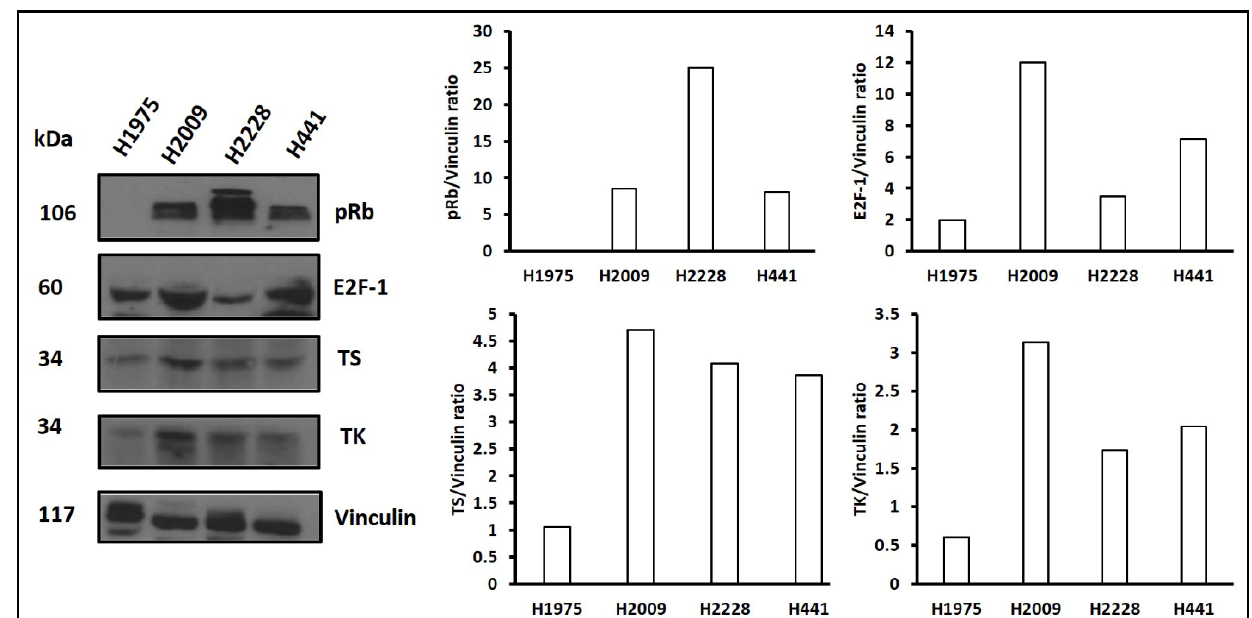
Figure 6. Western blot analysis of four non-small cell lung cancer cell lines. 12% SDS-PAGE was used and probe for phosphorylated retinoblastoma (pRb), E2F-1, thymidylate synthase (TS), thymidine kinase (TK), and vinculin as a control. The uncropped Western blots are shown in Figure S4B.